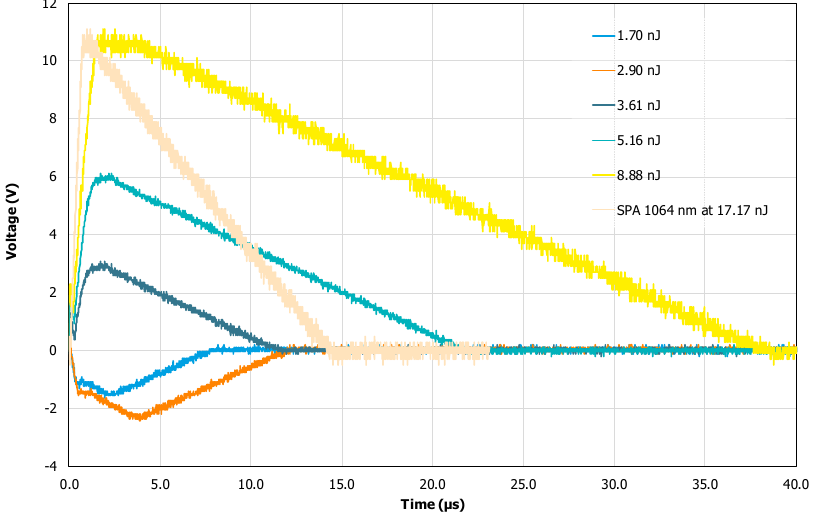
Figure 8. The response of the Q20 region to 1260 nm photons at different incident pulse energies. As can be seen from Figure 8, under the TPA test technology, the first transient pulse was observed when the pulse laser energy was 1.70 nJ, and the amplitude was about − 2.3 V with a negative polarity. Then, with the increasing pulse laser energy, the amplitude of the negative transient pulse decreased, and when the pulse laser energy was 3.61 nJ, the transient pulse became positive, and the amplitude of the transient pulse increased with the increasing pulse laser energy. The figure also shows a slope of the transient voltage of 1064 nm light when the laser energy was 17.17 nJ, which was induced by the SPA method at this time. It can be seen that the slope slopes of the transient voltage induced by SPA and TPA were